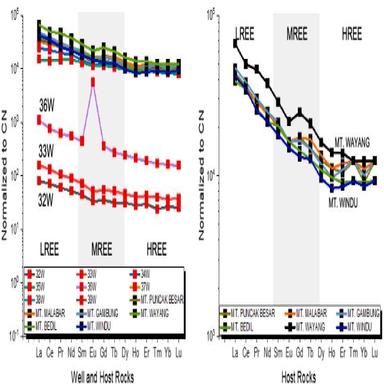
Spider-web diagrams of REE concentrations of the well and host rock samples (left) and of only the host rock samples (right) normalized by CN, showing only one Eu-positive anomaly for 36W and LREE enrichment opposite to that of the water samples.